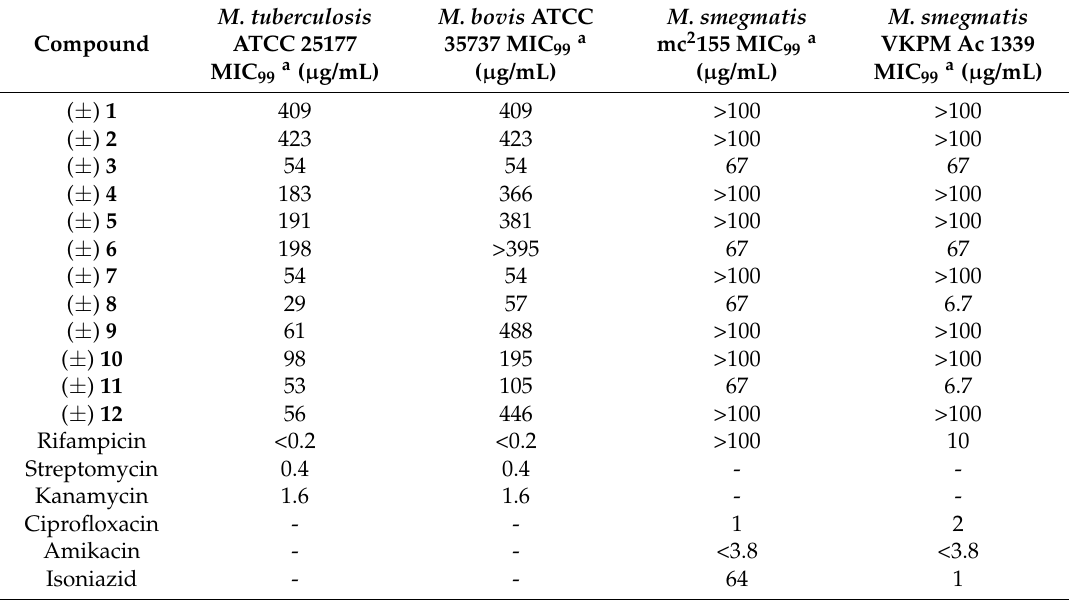
Table 1. Preliminary evaluation of antimycobacterial activity of compounds 1 – 12